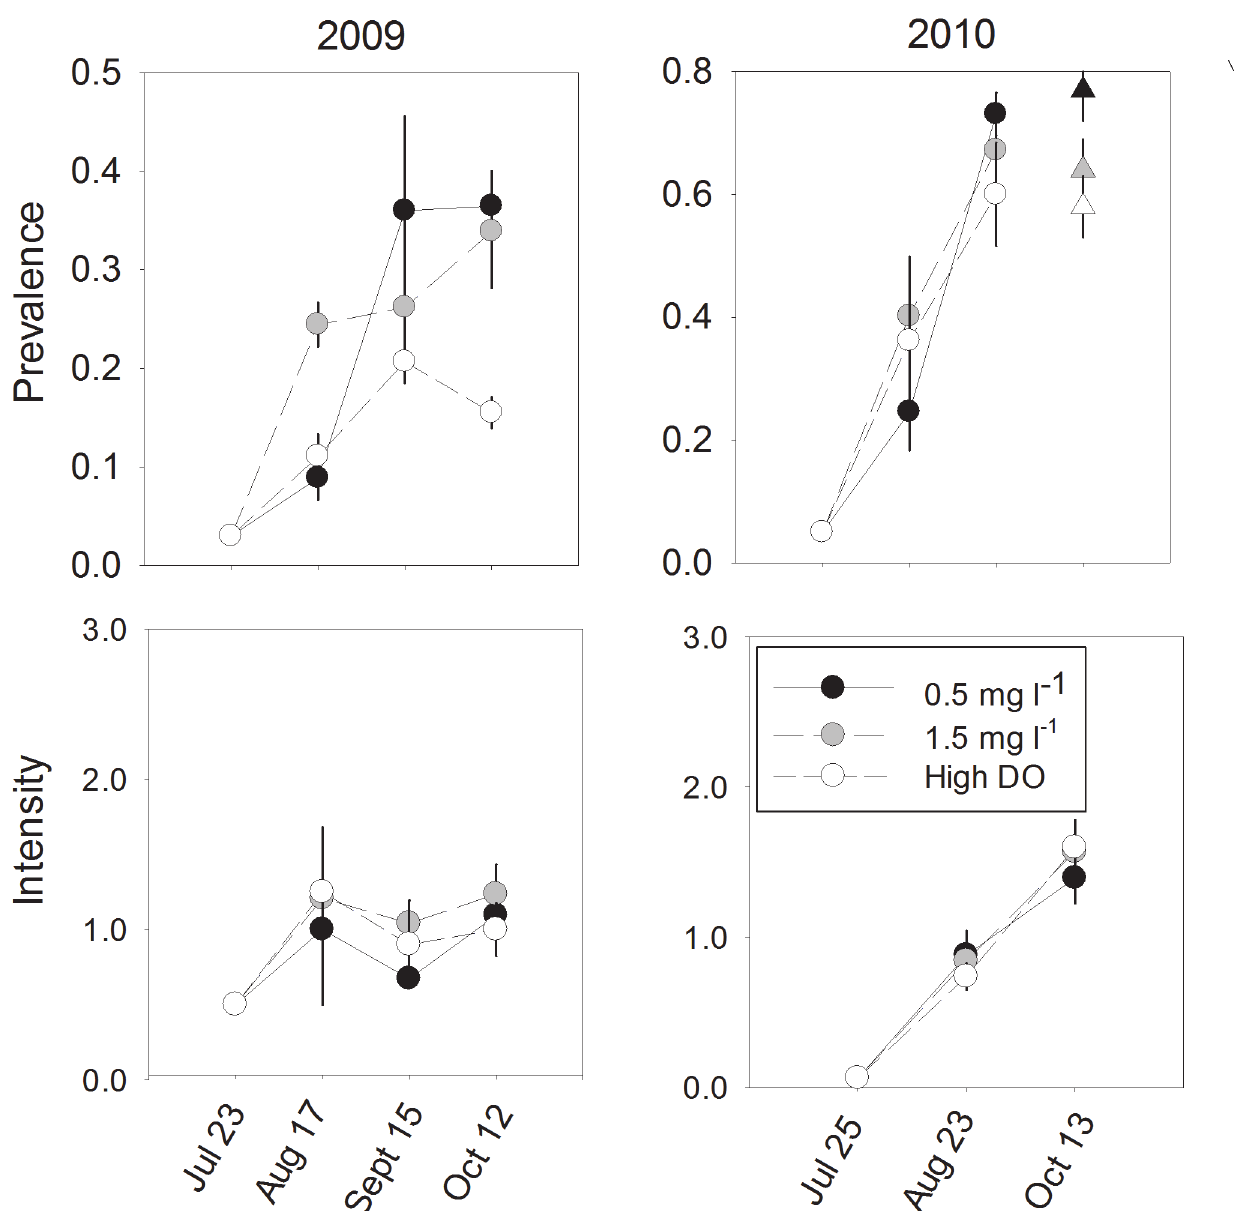
Fig 6. Prevalence and intensity of P . marinus infections in 1yo oysters in laboratory experiments (mean ± SE). Circles are means calculated from unadjusted data; triangles for 2010 1yo oysters show 13 October lsmeans for data adjusted for infection intensity in paired tanks containing 3yo oysters. Only infected individuals (i.e., Mackin score of 0.5 or greater) were included in intensity